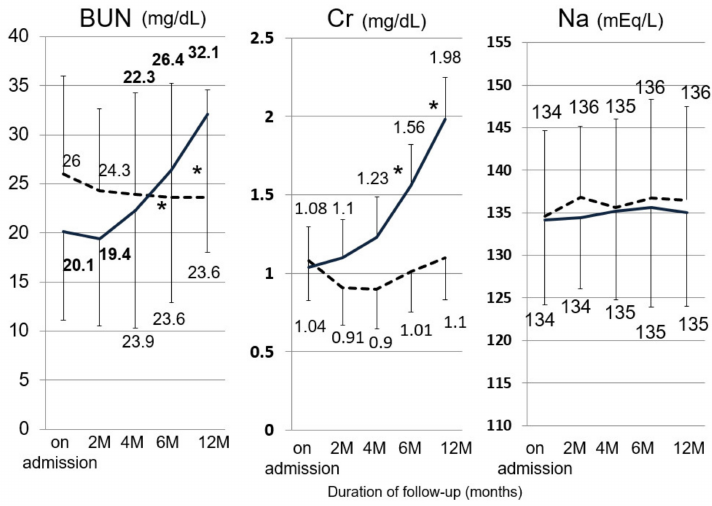
Figure 2. Serial changes in the serum concentration of BUN, creatinine, and sodium in the conven- tional therapy group and the tolvaptan group. Solid line: the conventional therapy group; dotted line: the tolvaptan group. Asterisks indicate significant differences (* p < 0.01 compared with the value recorded before